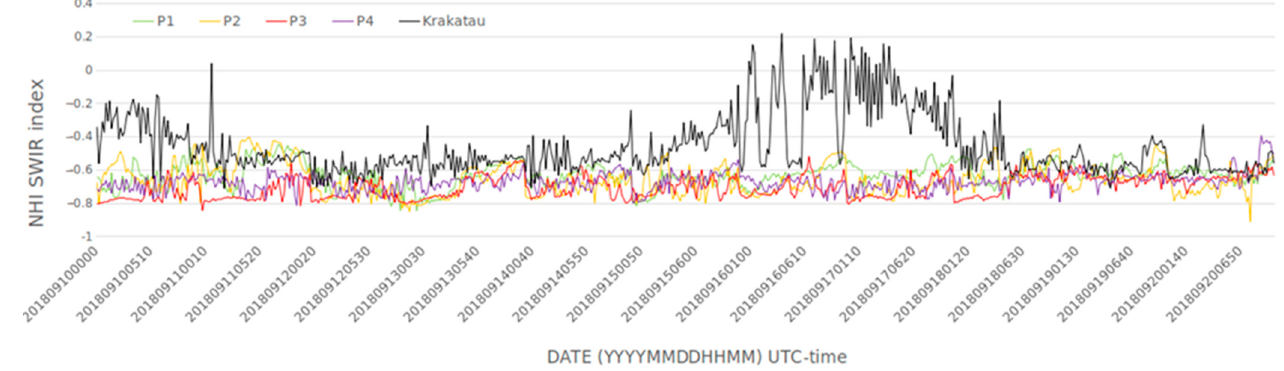
Figure 6. Time series of the NHI SWIR index computed, from Himawari-8 AHI data of Figure 5b, over the Krakatau (black curve) and four background pixels (from P1 to P4) located far from the volcano (see Figure 5a). Note that values of the index higher than − 0.4 were recorded only at Krakatau, in the presence of a documented lava effusion.